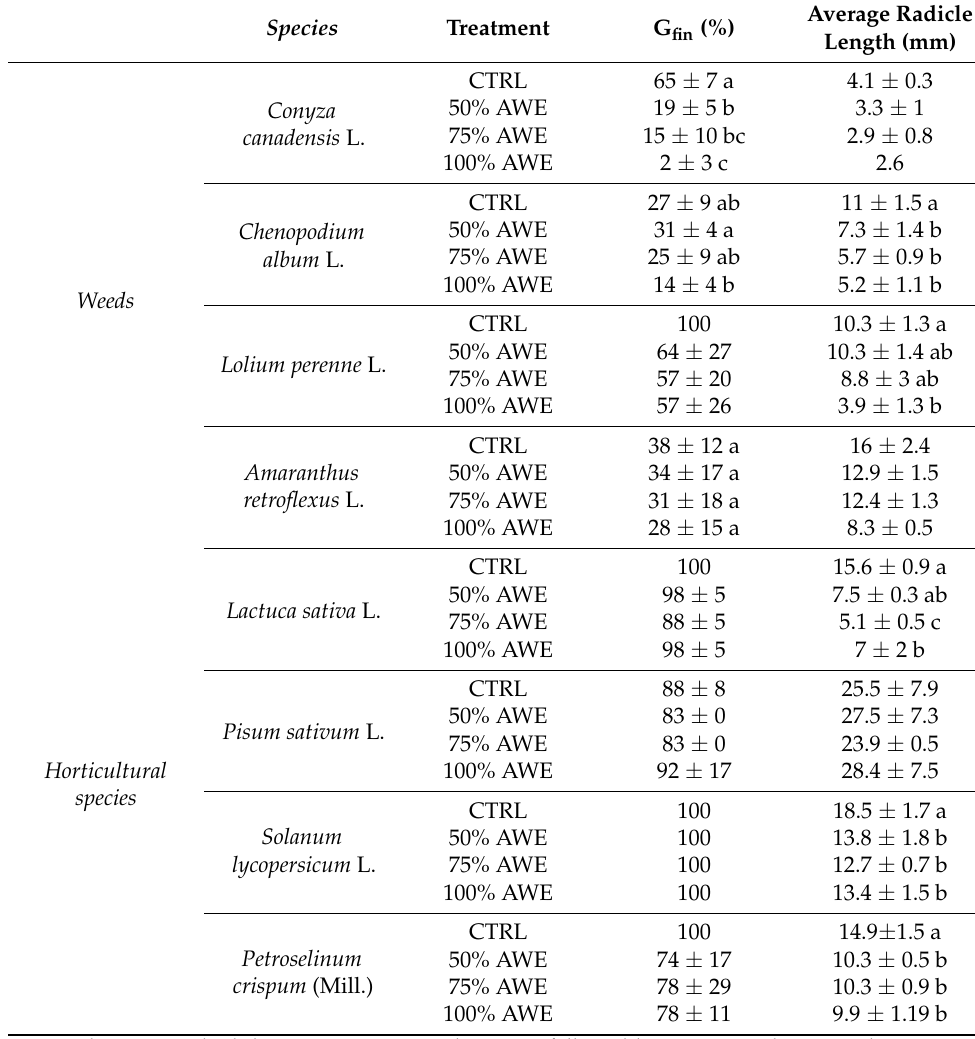
Table 4. Final germination rate (Gfin, %), average radicle length (mm) of weeds and horticultural species in the control (CTRL) and in AWE treatments at 50%, 75% and